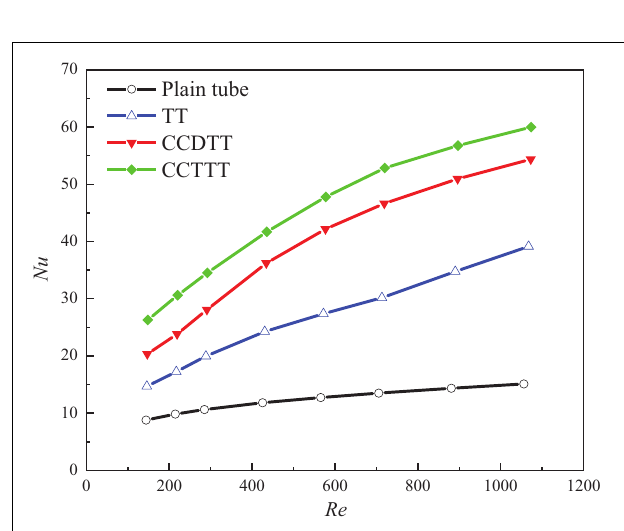
FIGURE 4 | Variation of friction factor with the Reynolds number for FLiBe in the plain tube and the tube fitted with TT, CCDTT, and CCTTT ( y = 3).